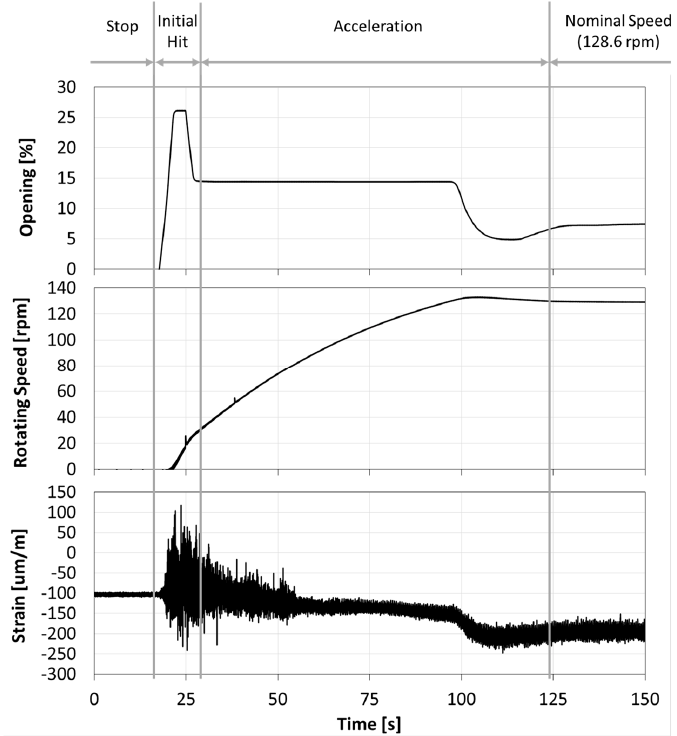
Figure 5. Time signal of the wicket gate opening, rotating speed and a strain gauge of the runner during the start-up of the machine.